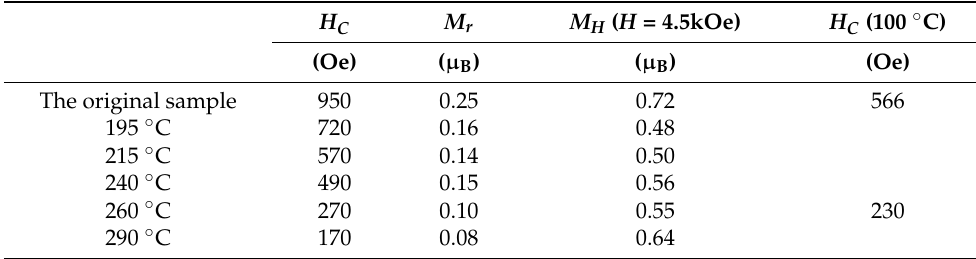
Figure 22. Hysteresis loop of a sample containing 5 mass. % of iron-containing nanoparticles in the volume of the polyethylene matrix: the initial sample (1) and demagnetization loops for air-heated samples at (2) 29 °C, (3) 240 °C, (4) 260 °C, and (5) 195 °C. Table 7. The value of residual magnetization ( M r ) and magnetization in a field with a value of 4.5 kOe (M H ) and coercive force ( H C ) at room temperature and 100 ◦ C for a sample that has been heat treated at different temperatures